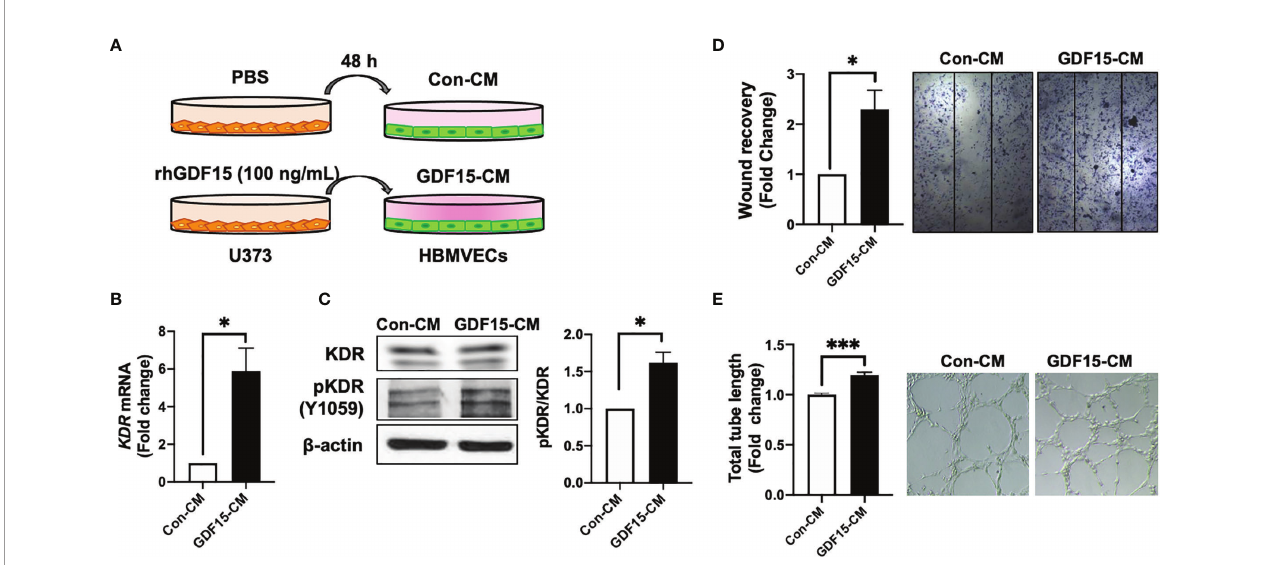
FIGURE 4 | GDF15-induced VEGFA activates angiogenesis. (A) Schematic representing human brain microvascular endothelial cells (HBMVECs) cultured in control conditioned medium (Con-CM; conditioned medium from U373 cells) or GDF15-CM (conditioned medium from rhGDF15-stimulated U373 cells); (B) KDR mRNA expression in HBMVECs was measured using quantitative reverse transcription polymerase chain reaction (qRT-PCR). (C) Phosphorylation of KDR was examined using western blotting ( b -actin as used as loading control); (D) Wound healing assay results. The day before the experiment, HBMVECs were seeded in 12-well plates (1.5 × 10 5 /well). The monolayer was scratched to introduce a wound and treated with Con-CM or GDF15-CM. The migration of cells into the wound area was analyzed after 24 h (signi fi cance compared with the cells cultured in Con-CM). (E) Tube formation assay results. HBMVECs (1.5 × 10 5 cells) were incubated on Matrigel matrix for 3 days with Con-CM or GDF15-CM. The tube length was measured using ImageJ angiogenesis analyzer (signi fi cance was compared with the cells cultured in Con-CM). (* p < 0.05 and *** p < 0.001 compared with the cells cultured in Con-CM).